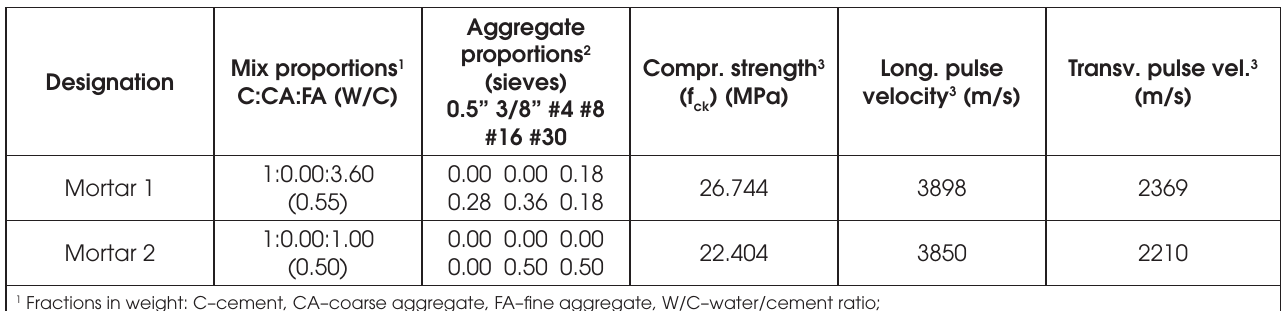
Mix proportions and mechanical